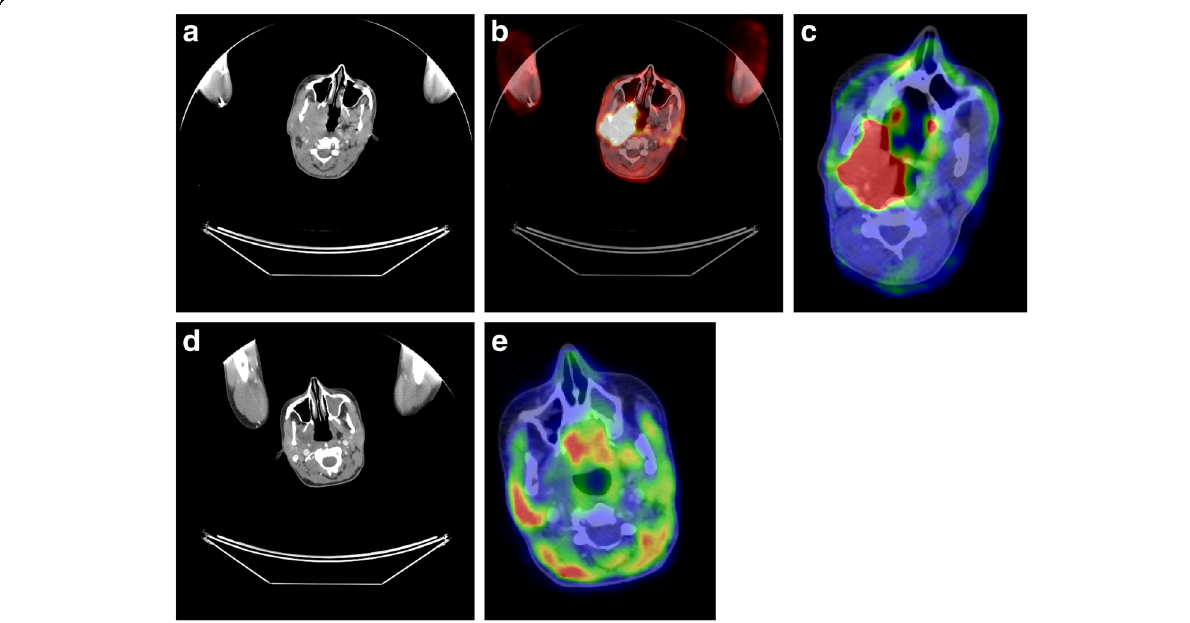
Fig. 3 A 25-year-old patient with large B cell lymphoma. a , b His initial study revealed a large ill-defined hypermetabolic right para-pharyngeal soft tissue mass lesion noted to be measuring about 5.7 × 7 × 7.5 cm achieving SUV max ~ 11.1. c , d His interment study revealed regressive course as regards the size of the previously reported soft tissue mass lesion roughly measuring about 2.5 × 2.5 × 5 cm; the mass is non-FDG avid with total metabolic response. This case showed partial regression by CT and total regression by